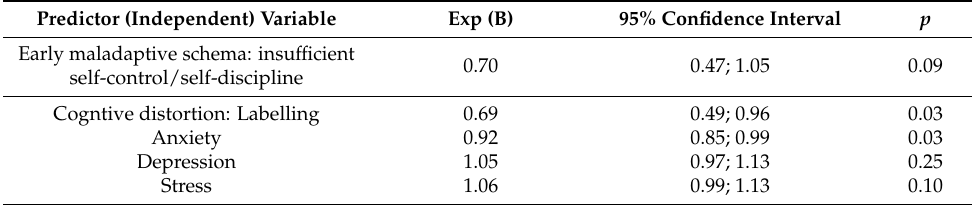
Table 5. Results of multivariable (logistic regression) analysis with presence or absence of morbid obesity as dependent variable * (Model Nagelkerke R 2 =